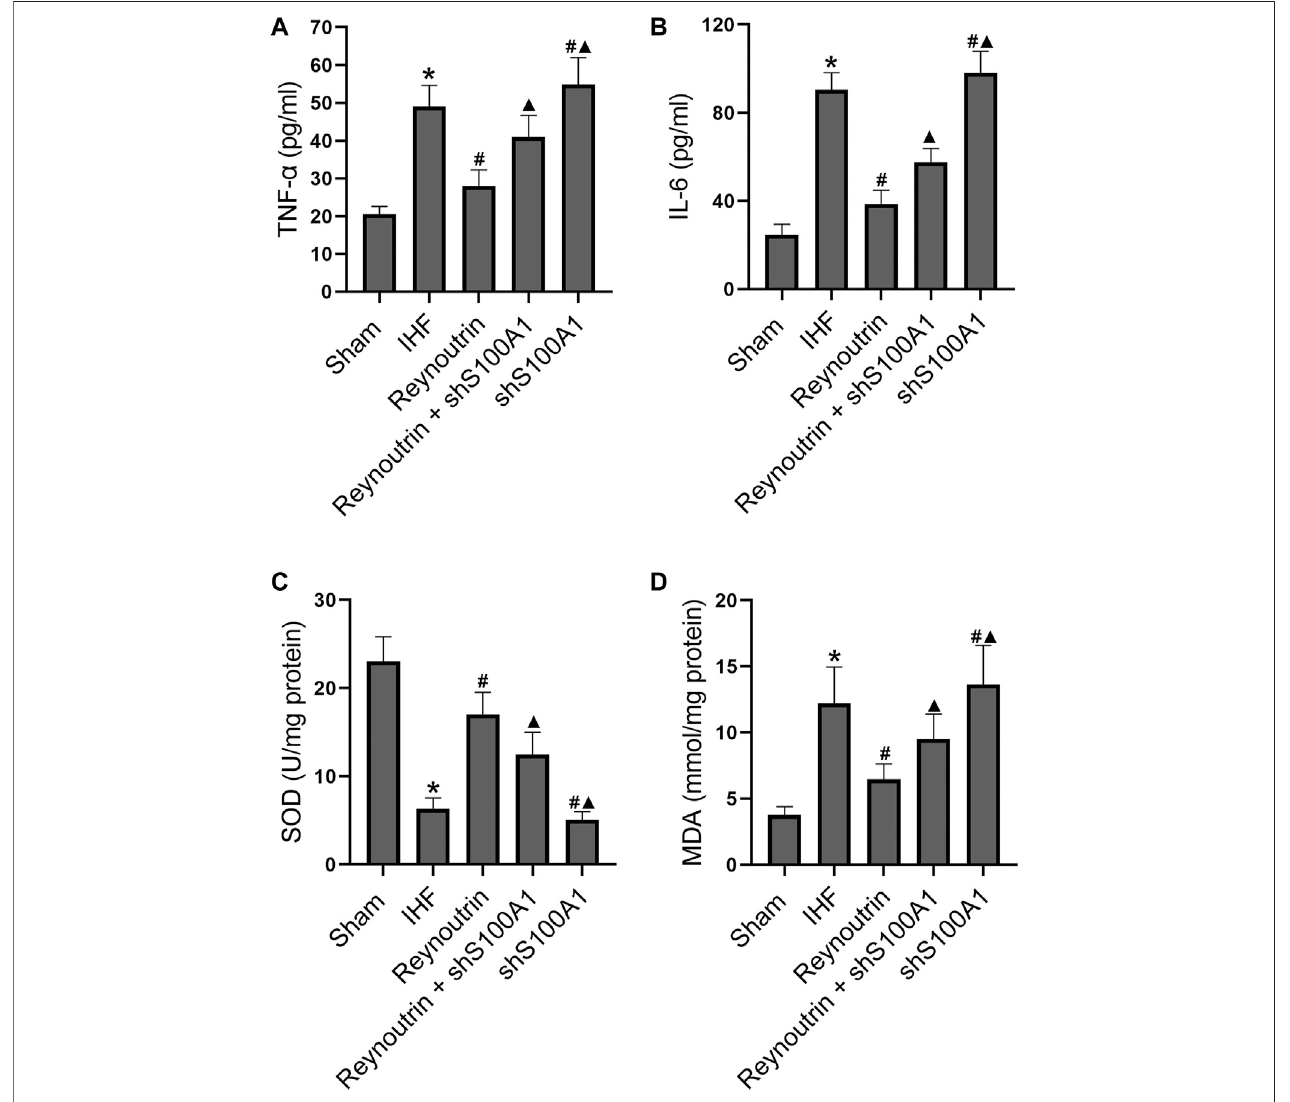
FIGURE 5 | Effects of reynoutrin and S100A1 knock-down on the levels of TNF- α , IL 6, SOD and MDA in rats. The dose of reynoutrin here was 50 mg/kg. (A) The concentration of TNF- α in serum of each group. (B) The concentration of IL six in serum of each group. (C) The concentration of SOD in myocardium of each group. (D) The concentration of MDA in myocardium of each group. The values presented as the means ± standard error in each experiment group ( n (cid:1) 10). * p < 0.05 vs. Sham group; # p < 0.05 vs. IHF group; ▲ p < 0.05 vs. Reynoutrin group.